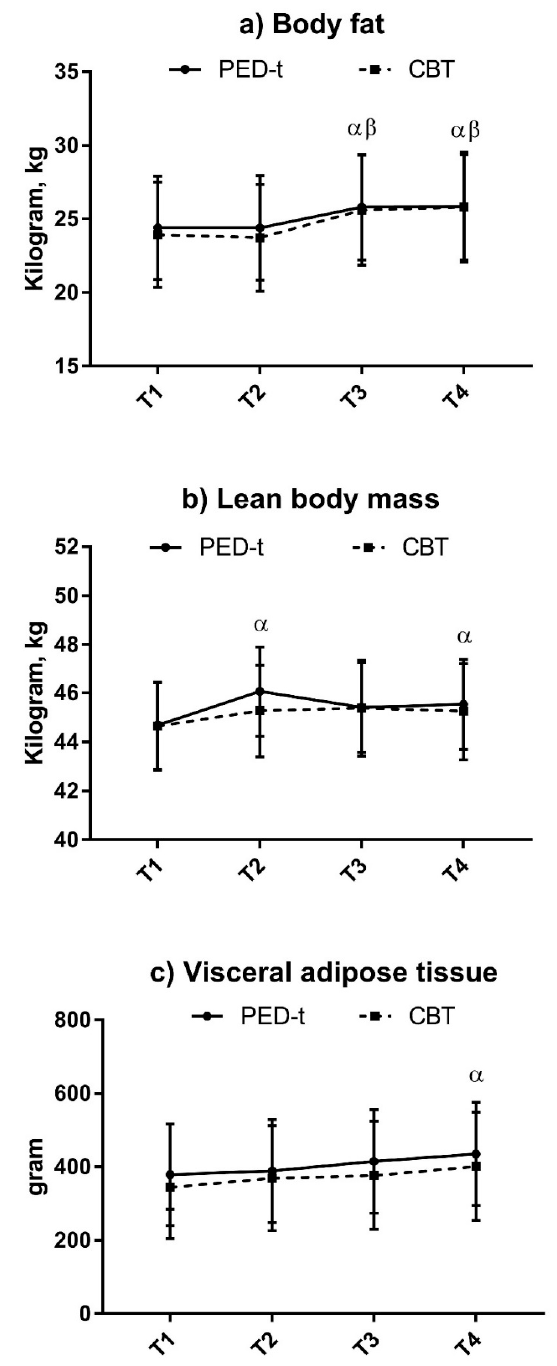
Figure 2. Changes in soft tissue body composition after PED-t or CBT. Results are estimated means (99% CI). ( a ) Changes in total body fat (kg); ( b ) changes in lean body mass (kg); ( c ) changes in visceral adipose tissue (gram). PED-t: Physical Exercise and Dietary therapy; CBT: Cognitive Behavior Therapy; 99% CI: 99% confidence interval; T1: baseline; T2: post-treatment; T3: 6 months post-treatment; T4: 12 months post-treatment; α : significant within-group change from T1 in PED-t ( p < 0.01); β : significant within-group change from T1 in CBT ( p < 0.01).